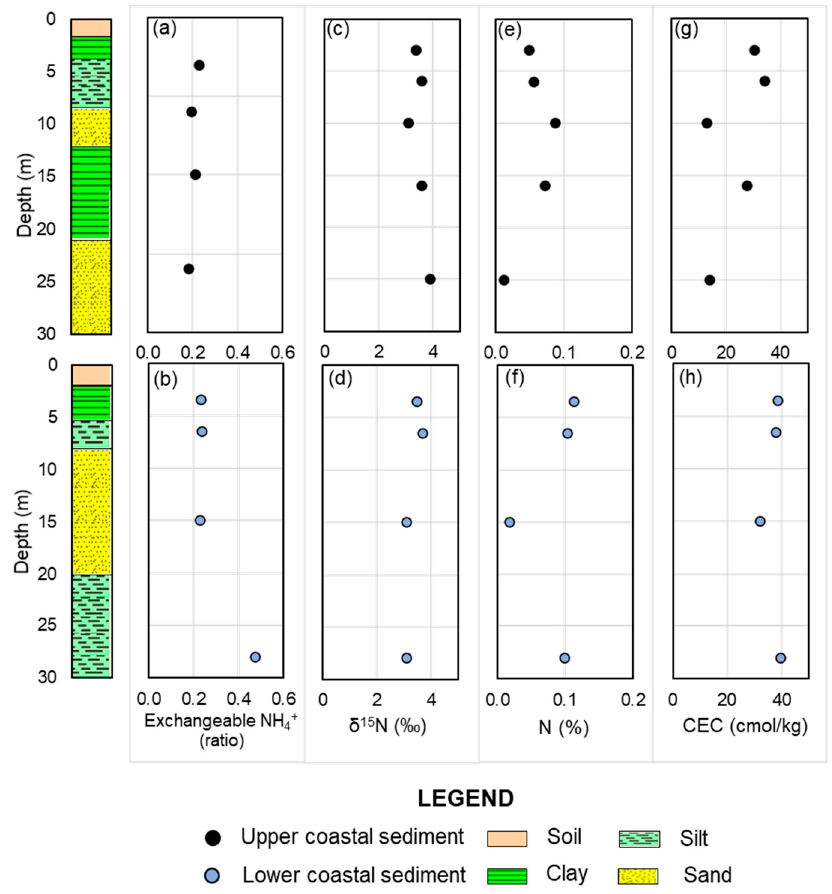
Figure 4. Exchangeable NH 4+ ratio ( a , b ), δ 15 N ( c , d ), %N ( e , f ), and cation exchange capacity (CEC) ( g , h ), in the sediments of the upper and lower coastal area.